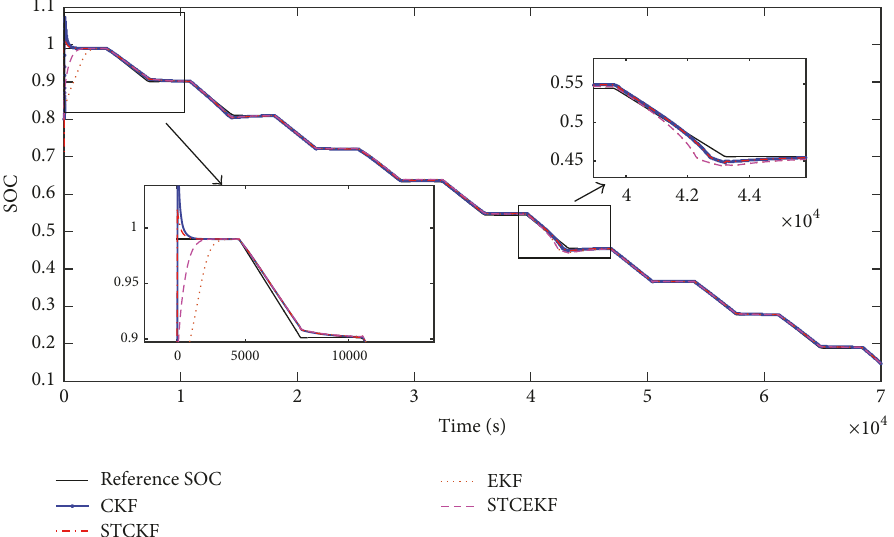
Figure 11: SOC estimation results using EKF, STEKF, CKF, and STCEKF at 25 ∘ C.